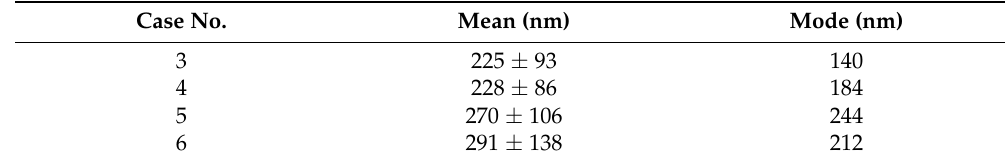
Table 1. Size distribution of extracellular vesicles (EVs) from gastric juice (GJ) of gastric cancer (GC) patients.